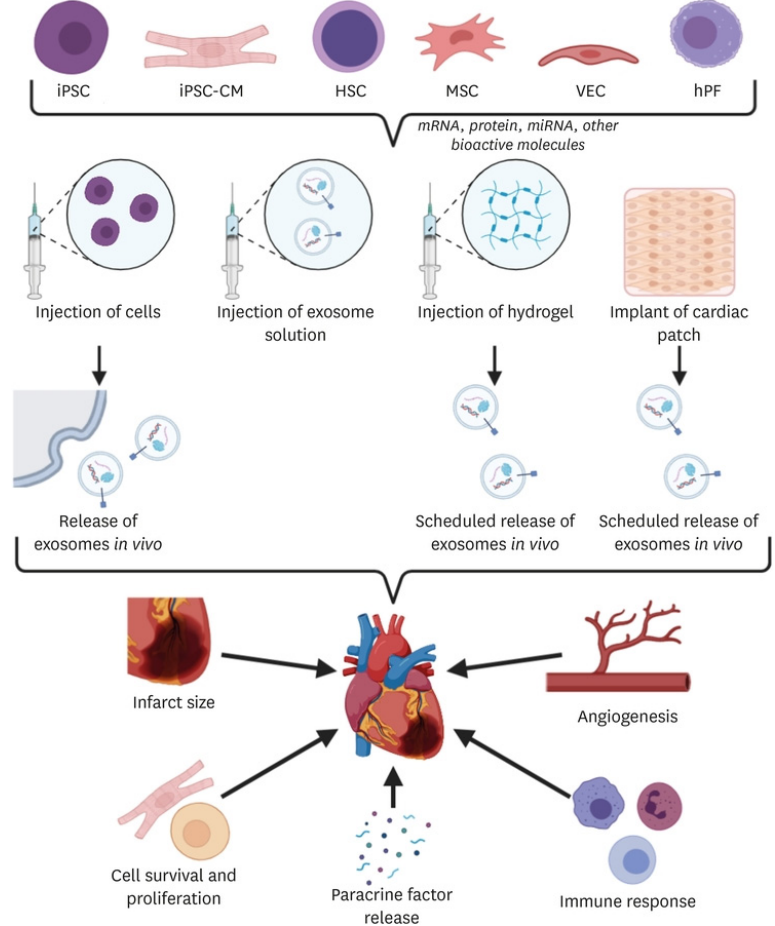
Figure 6. Schematic representation of possible strategies involving extracellular vesicles for endog- enous cardiac regeneration. Adapted from [11] . nous cardiac regeneration. Adapted from